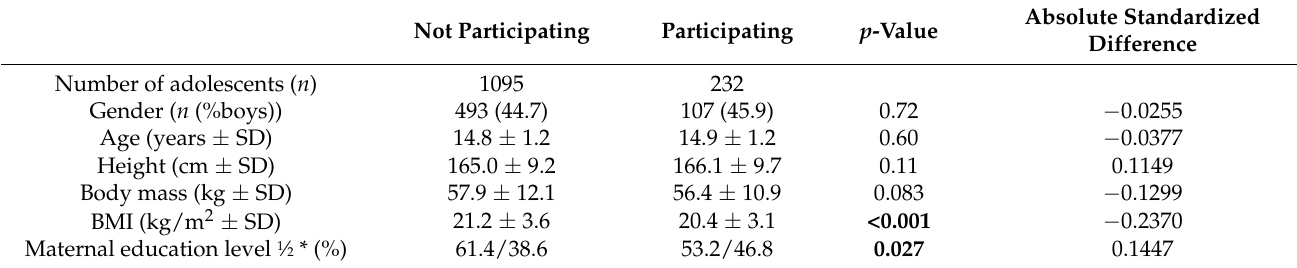
Table 6. Characteristics at adolescence of included and non-included subjects.